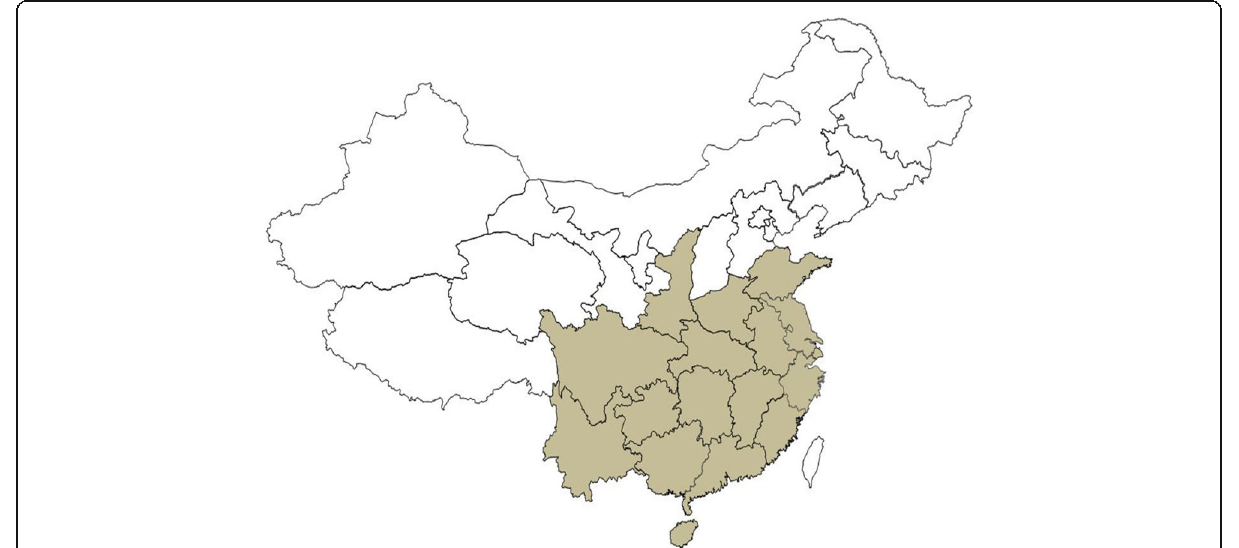
Fig. 3 Provinces where SY63 is planted on a significant area in China